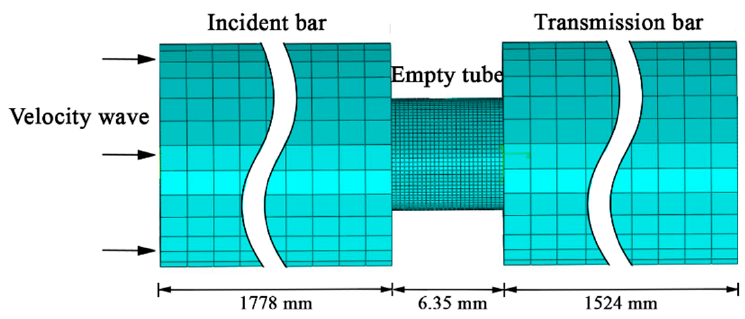
Figure 3. Finite element model of empty tube under split Hopkinson pressure bar.